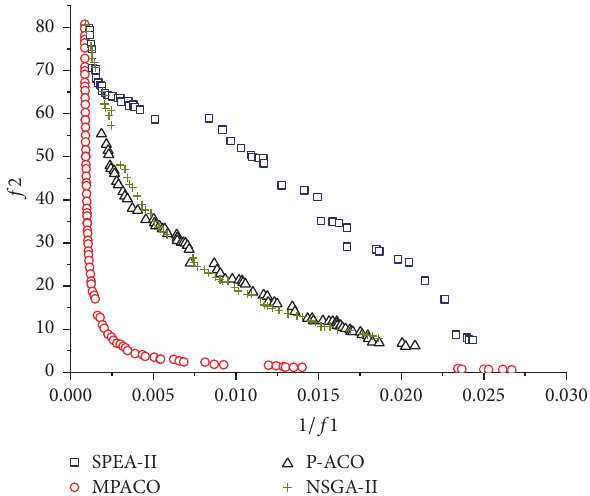
Figure 7: Plots of PSs best performance in 30 runs of four algorithms on Scale 3 .